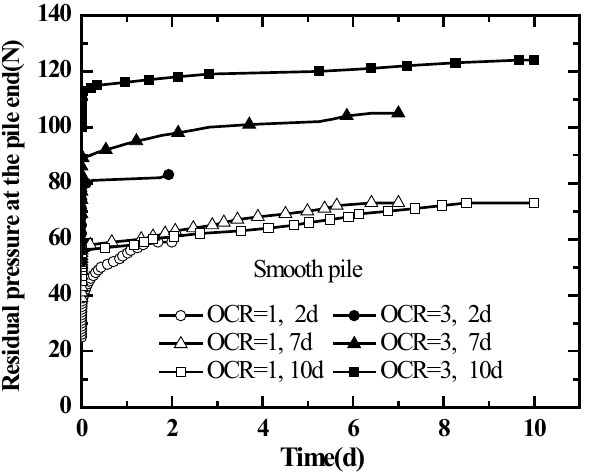
Figure 8. Curves for residual pressure at the smooth pile end varying with time.